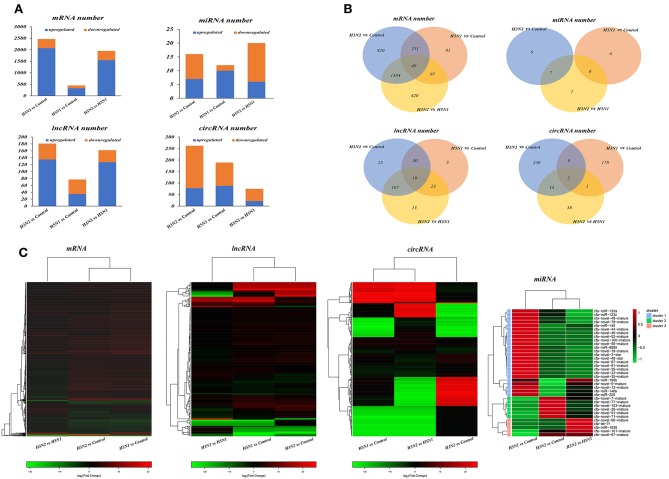
(A) Statistical histogram of the differential expression analysis. The horizontal axis represents the comparison and the vertical axis shows the number of differentially expressed transcripts. Orange represents downregulated transcripts, and blue represents upregulated transcripts. (B) Differentially expressed transcripts. In the Venn diagram, different comparison groups are represented by different colors. The numbers in the figure represent specific or common differences in the number of transcripts. The overlapping areas represent the number of differentially expressed transcripts shared by different comparison groups; the non-overlapping areas represent the number of differentially expressed transcripts that were unique to the different comparison groups. (C) Heat map of differentially expressed transcripts based on fold changes. Each row represents a transcript and each column represents a comparison group. Red indicates upregulated expression, and green indicates downregulated expression.